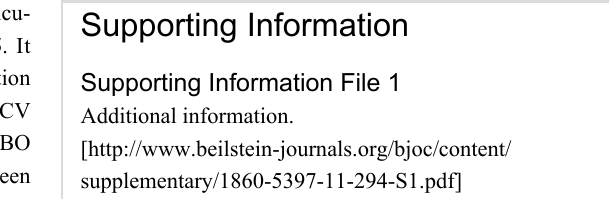
a reasonable correlation between the occupation of the p( π ) AO at the C carb atom and the energy which is associated with the X → p( π ) π